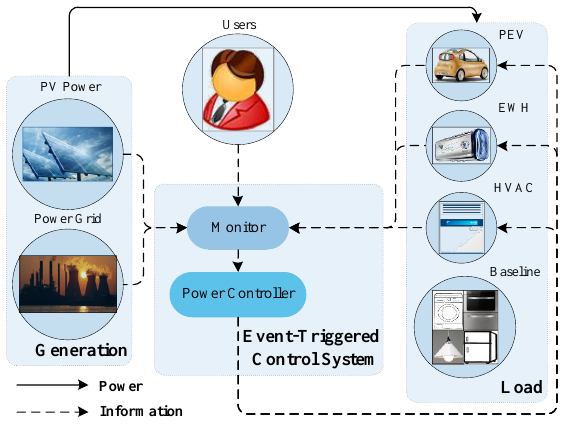
Figure 1. Overview of a Home Energy Management System